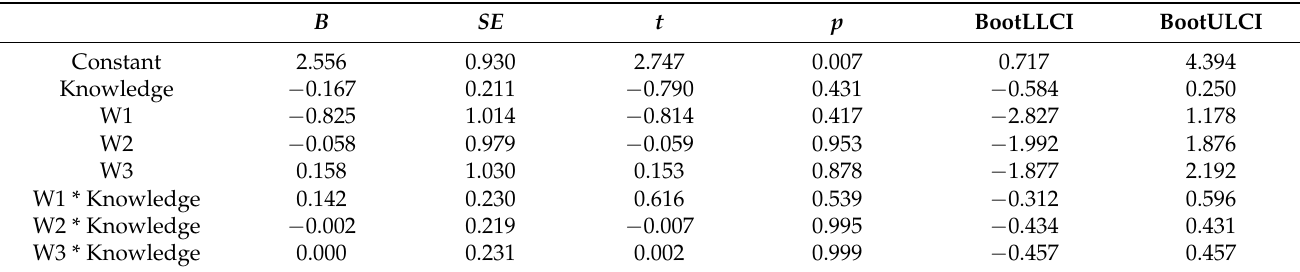
Table 5. Moderation effect of educational qualification in the relationship between COVID-19 knowledge and